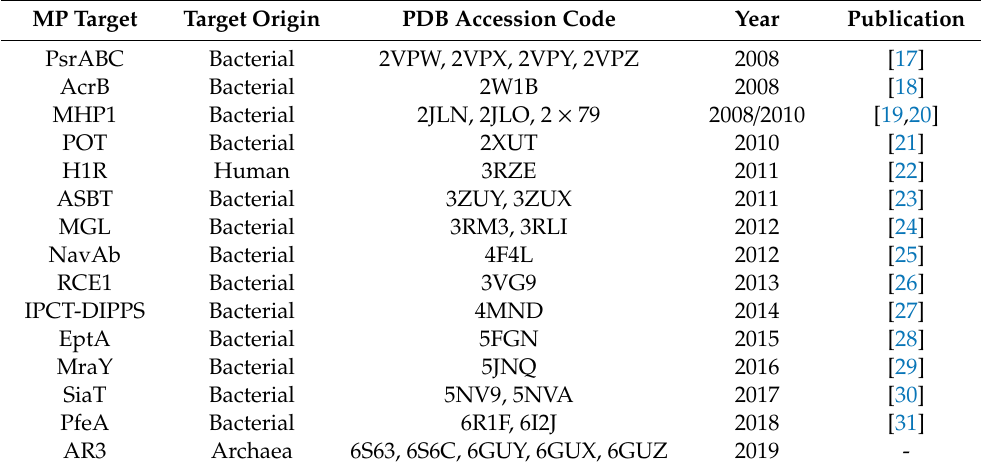
Table 1. Membrane protein (MP) structures that have been supported by the work of MPL